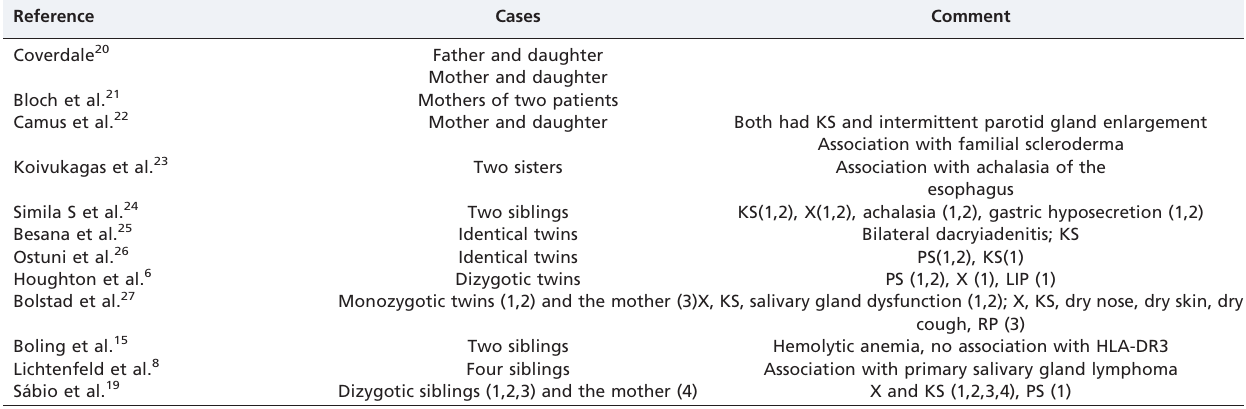
Table 1 - Case reports of familial Sjo¨gren’s